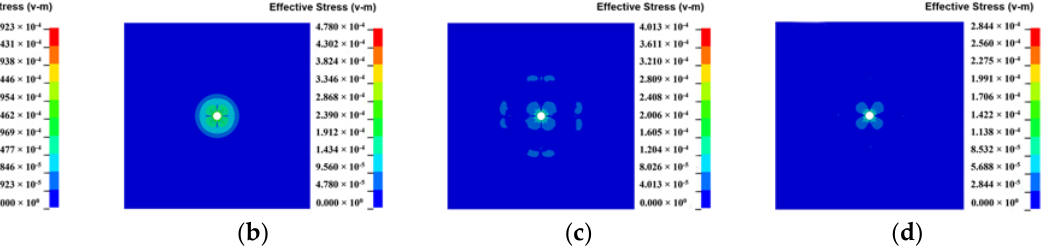
Figure 4. Effective stress nephograms of coal under the action of HPAB: ( a ) 15 µ s; ( b ) 30 µ s; ( c ) 100 µ s; ( d ) 200 µ s.